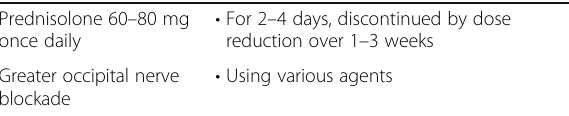
Table 14 Transition therapies used in cluster headache by specialists